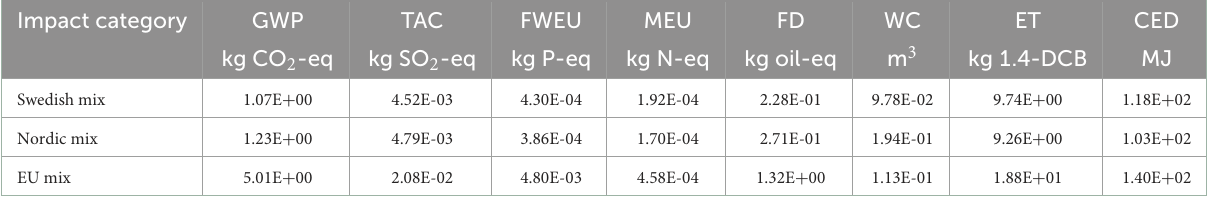
TABLE 3 The sensitivity to the choice of electricity mix, results for the Swedish, Nordic and EU grid mixes for the impact categories under study. Impact category